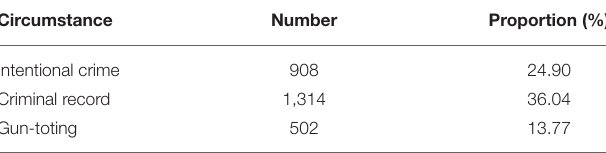
TABLE 3 | The subjective aspects (intentional crime).